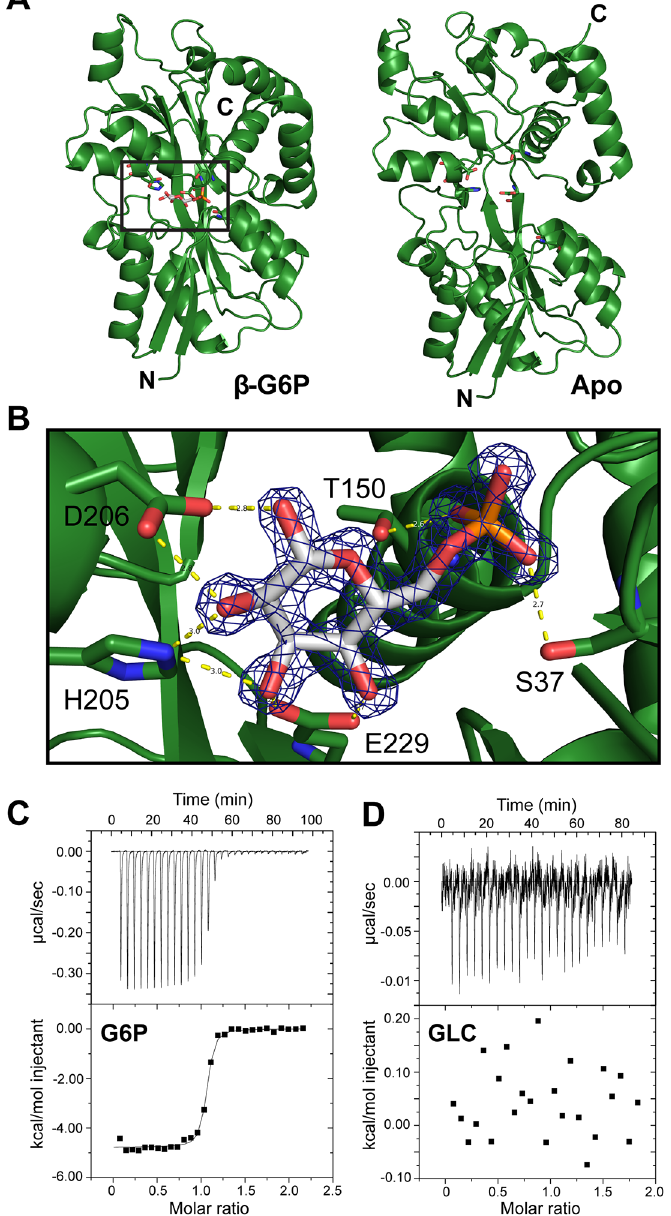
Fig 1. AfuA is a sugar-phosphate specific periplasmic binding protein. (A) Ribbon diagrams of A . pleuropneumoniae AfuA complexed with either no ligand (right) or β -G6P (left). (B) Cleft region of AfuA depicting 2F 0 -F c map contoured at 2 σ around β -G6P. Residues used for mutagenic studies are indicated with text labels. Predicted hydrogen bonds are drawn as yellow dashed lines with distances indicated in angstroms ( Å ). (C) Representative ITC curve for a positive AfuA-ligand interaction. The curve shown is from a titration of A . pleuropneumoniae AfuA with a 10:1 ratio of G6P. (D) Representative ITC curve illustrating lack of an AfuA-ligand interaction. The curve shown is from a titration of A . pleuropneumoniae AfuA with a 10:1 ratio of